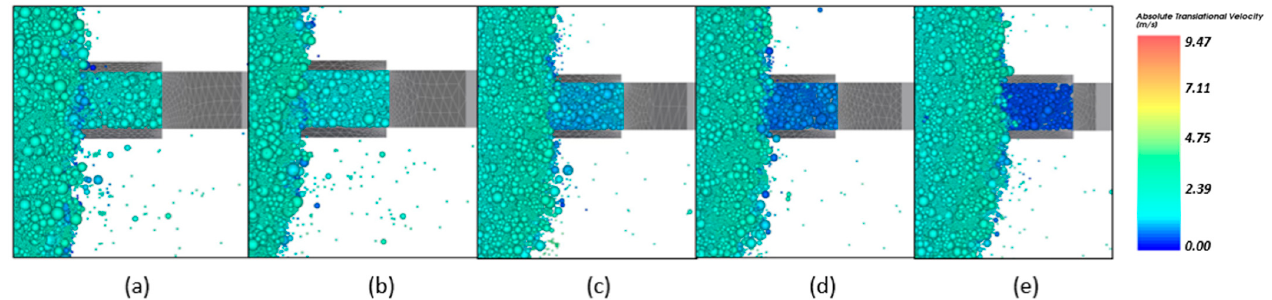
Figure 8. Top view of the system showing particles inside the cutter. Particles are colored according to their velocity being: dark blue low velocity and light blue high velocity. ( a ) Simulation 05: 60°, ( b ) Simulation 04: 50°, ( c ) Simulation 03: 40°, ( d ) Simulation 02: 30°, ( e ) Simulation 01: 20°.